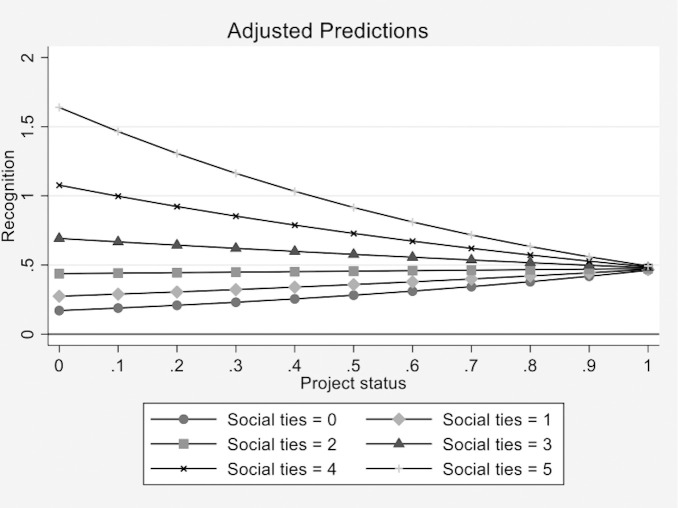
Adjusted predictions for the number of social ties at representative values of project status.